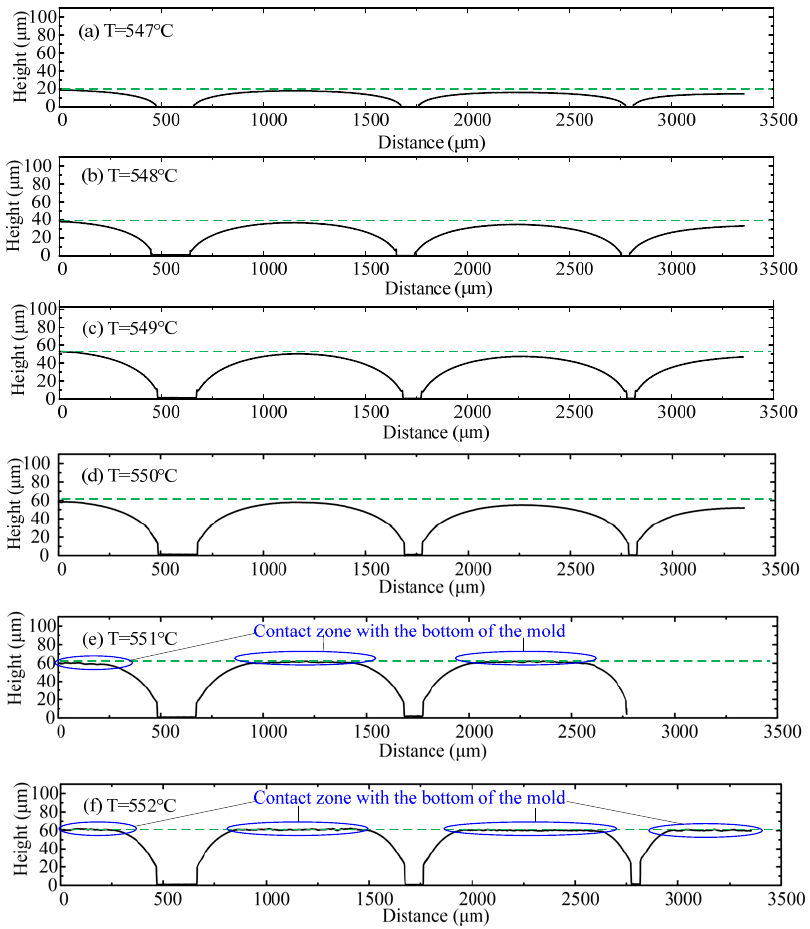
Figure 5. The profiles of the molded grooves at different molding temperatures. ( a ) 547 ◦ C; ( b ) 548 ◦ C; ( c ) 549 ◦ C; ( d ) 550 ◦ C; ( e ) 551 ◦ C; ( f ) 552 ◦ C.